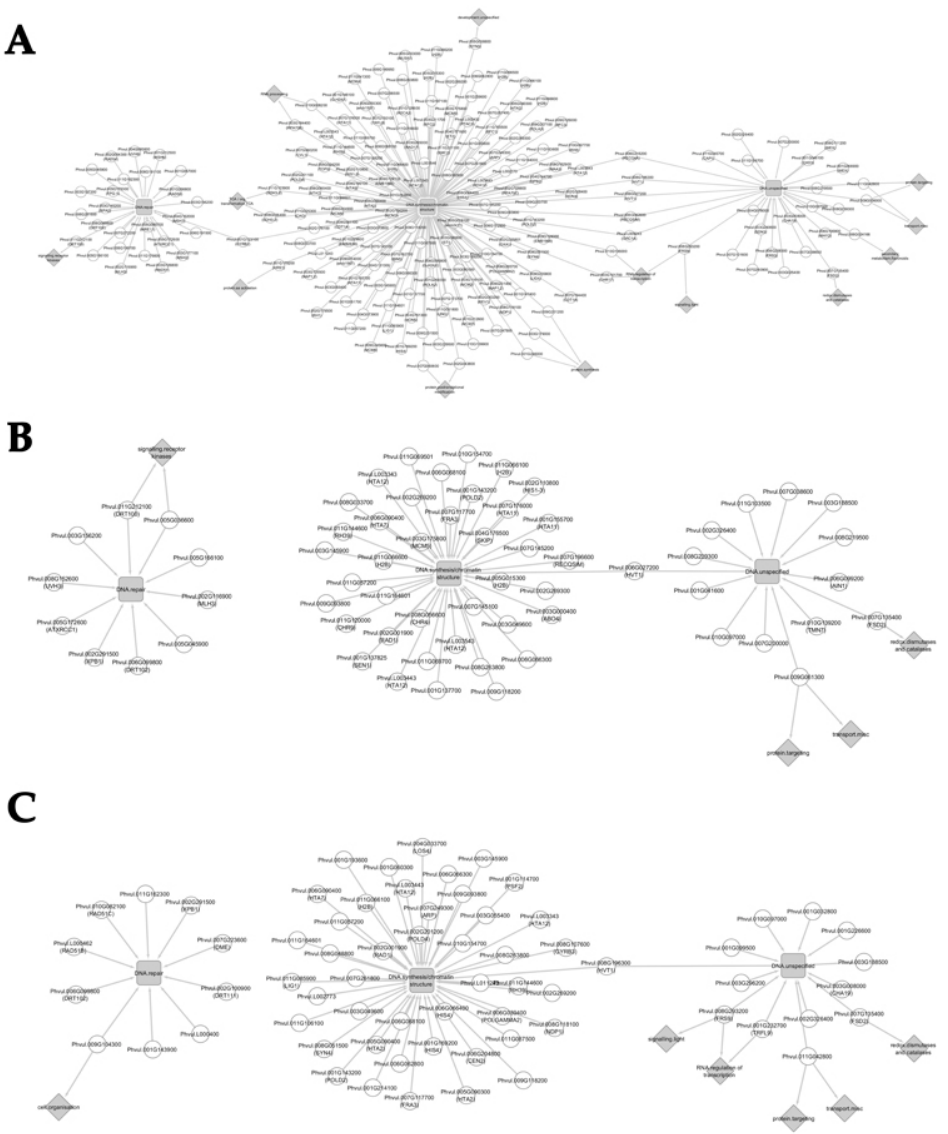
Figure 6. Network analysis of expressed genes between two consecutive seed development stages using the expressed genes (EGs) belonging to MapMan functional category “DNA” that changed expression at least 2-fold. For the same EGs, complementary functional categories resulting from MapMan categorization are also evidenced. Grey squares represent MapMan functional subcategories of “DNA”, gray diamonds represent other MapMan functional categories beside “DNA” and white circles represent EGs with changed expression in a comparison. Comparisons between time points are shown: ( A ) 10 DAA vs. 20 DAA; ( B ) 20 DAA vs. 30 DAA; ( C ) 30 DAA vs. 40 DAA. DAA: days after